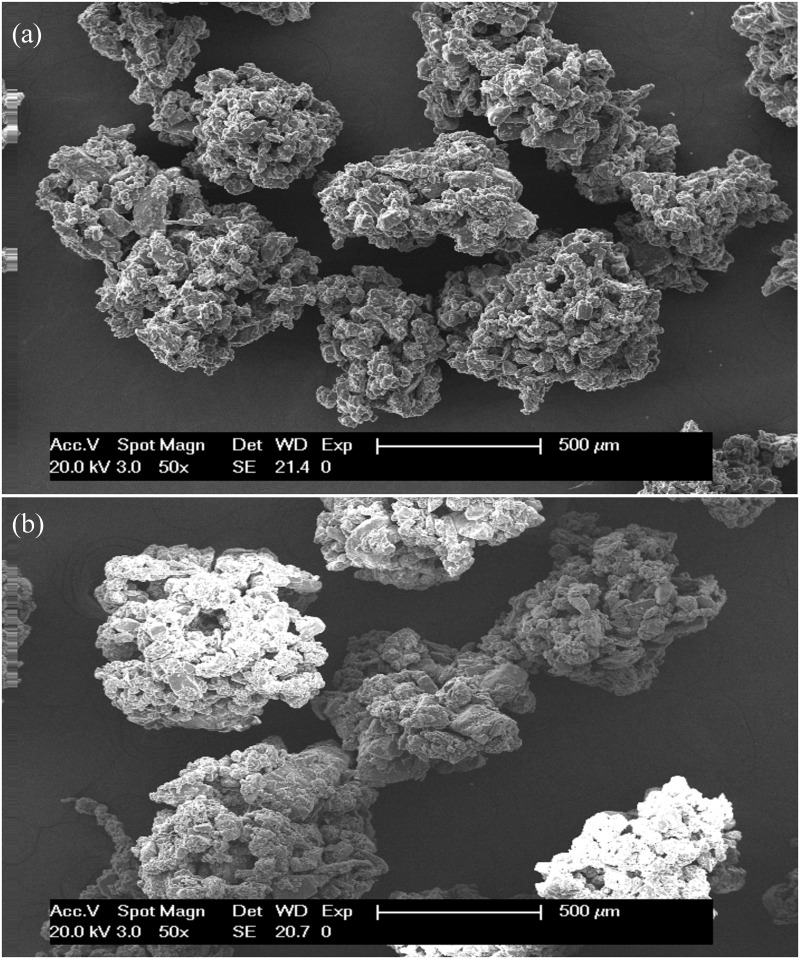
SEM micrographs of: (a) granules obtained by T1 and (b) granules obtained by T2.